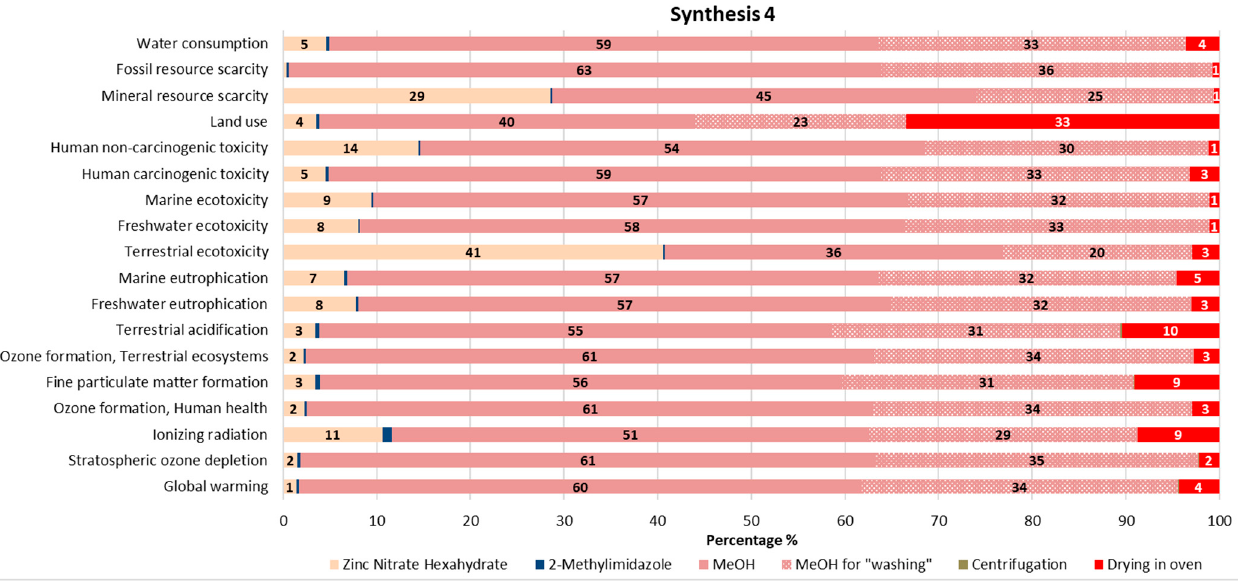
Figure 7. Life Cycle Assessment of the 4th synthetic approach of ZIF-8. Method: ReCiPe 2016, midpoint (H) V.1.01.